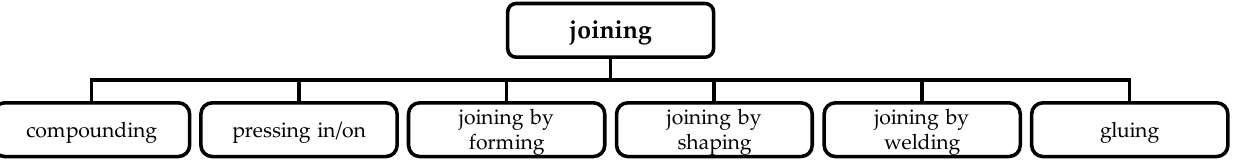
Figure 1. Joining groups relevant for plastics.